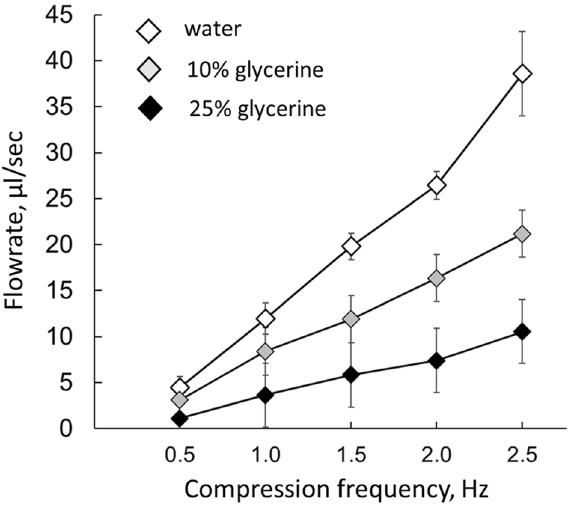
Figure 3. The flowrate–frequency relationship. Within the examined range of frequencies and viscosities, an increase in compression frequency led to a linear increase in the net flowrate. The values shown in this graph were acquired using a 38-mm-long, 5-mm-wide compliant segment with wall thickness of a 0.5 mm. The pincher was located 2 mm from the junction. The corresponding Womersley numbers are listed in the